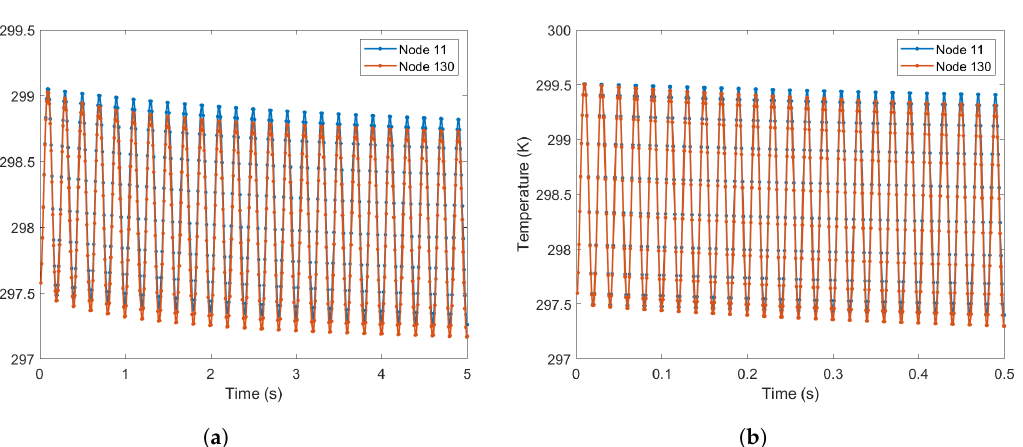
Figure 10. Temperature variation with time in the specimen for different frequencies and orthotropic